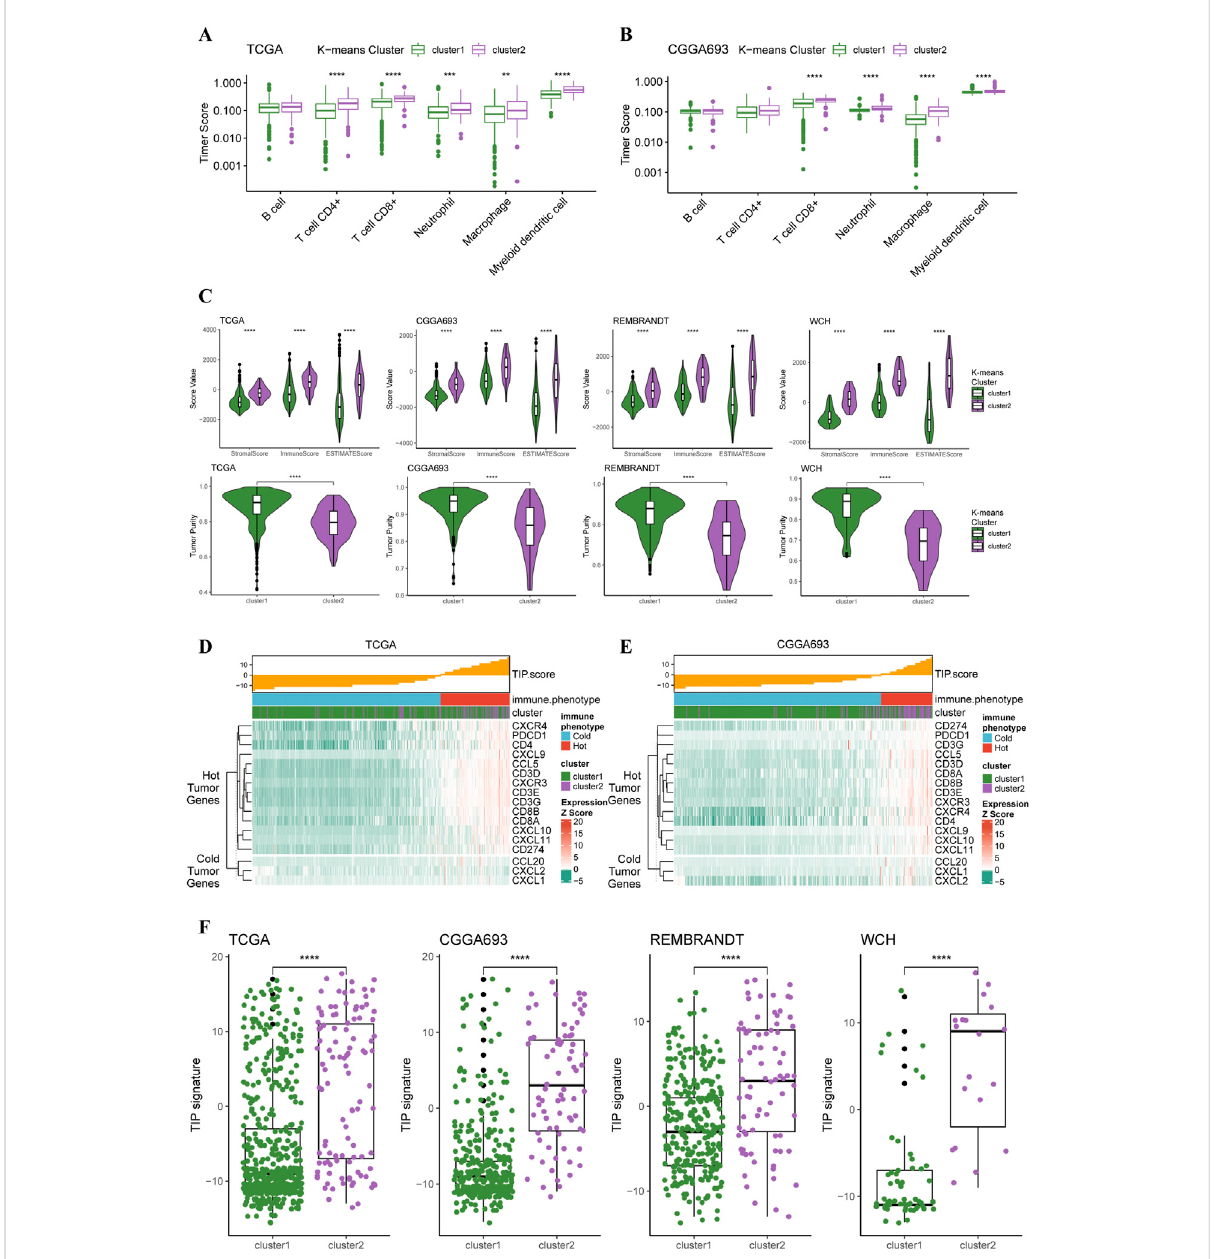
FIGURE 3 Different immunological features of tumor microenvironment between two clusters. (A) Boxplots of in fi ltration of six types of immune cells in glioma based on TIMER score in TCGA cohort (cluster 1: N = 556, cluster 2: N = 106) and (B) CGGA cohort (cluster 1: N = 339, cluster 2: N = 76). (C) Differences in stromal, immune, and ESTIMATE scores between two clusters in all four cohorts. (D) TIP score and related gene expression levels betweentwoclustersinTCGAand (E) CGGAcohort. (F) BoxplotswitheverypointonthedifferencesinTIPscorebetweentwoclustersinallfour